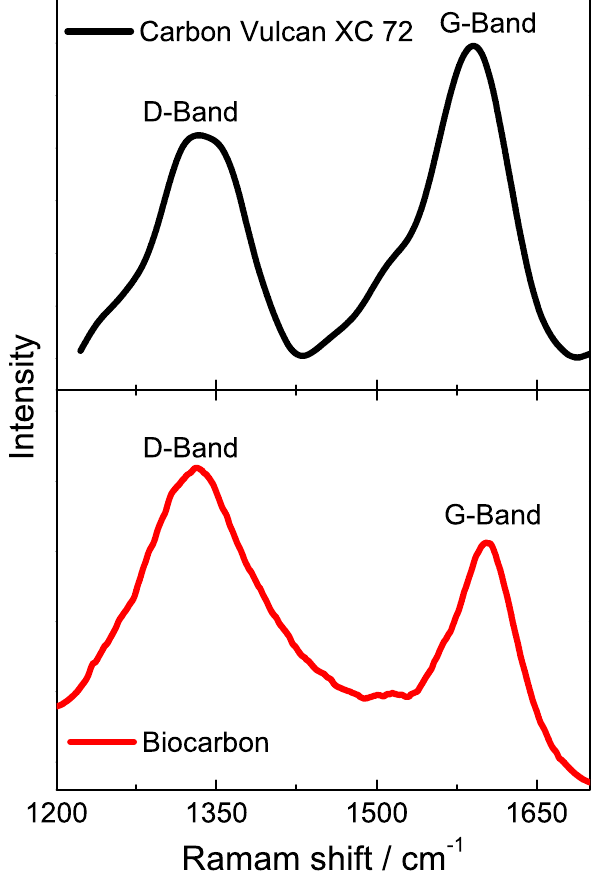
Fig. 2 Raman spectra of carbon Vulcan XC 72 and